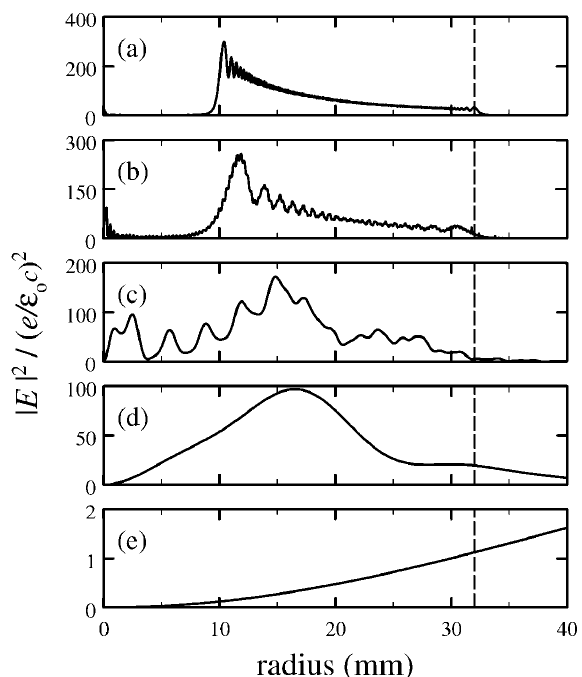
FIG. 4. Radiation distribution at the extraction window from a mirror with a hole radius of 9.5 mm when the window is located 64 mm from the straight section axis. The dashed line shows the 32-mm radius of the window. (a) l (cid:1) 10 m m, (b) l